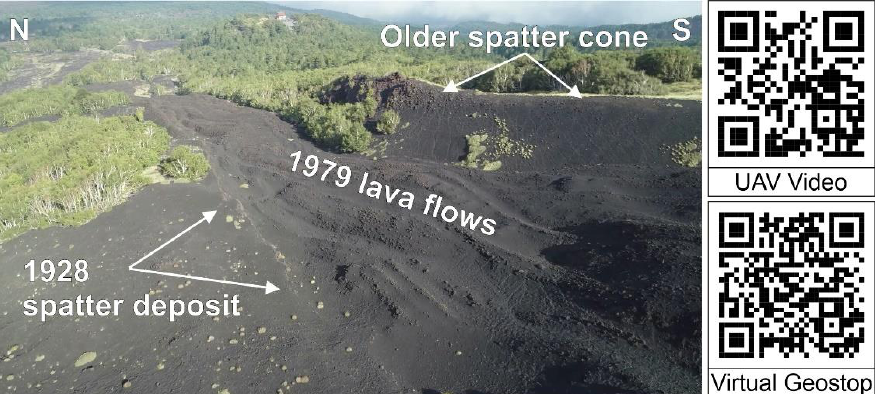
Figure 6. The image on the left shows geostop 4 through an E-looking UAV-captured picture. The QR codes on the right enable opening the corresponding UAV-captured video and the related VG. By using a mobile phone or a tablet, open up the QR code reader. Hold your device over a QR code, so that it is clearly visible on your screen. Press the notification and wait a few seconds.